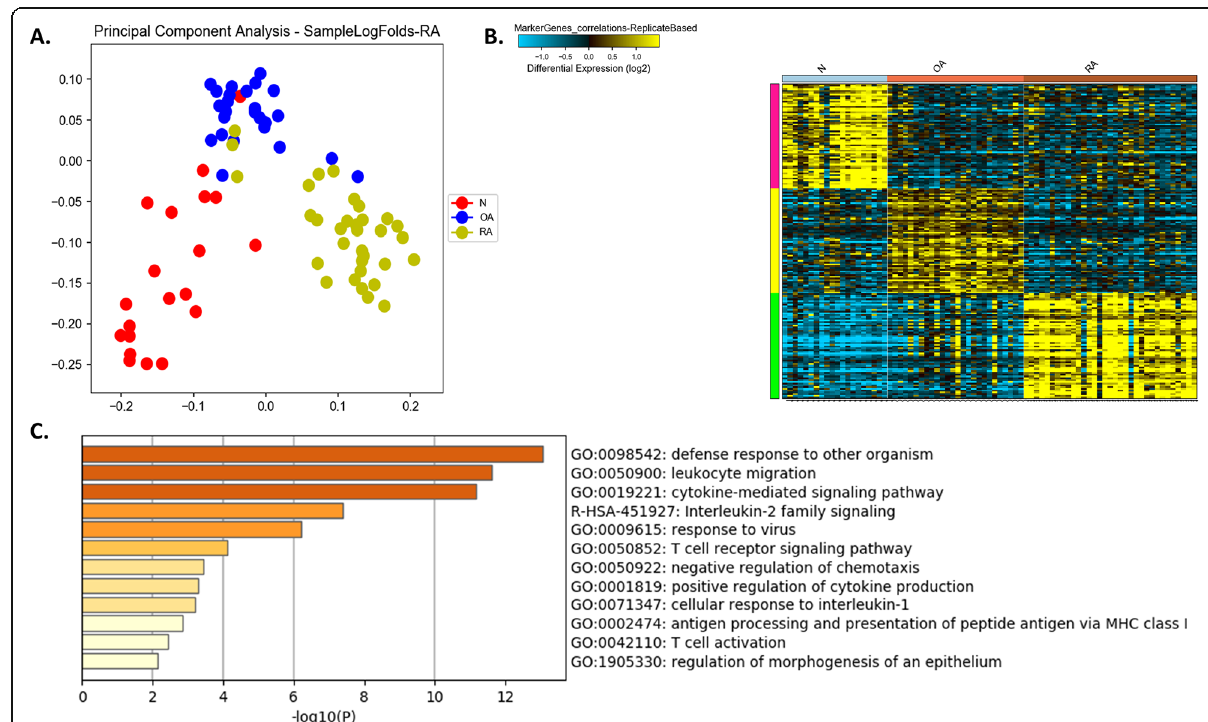
Fig. 1 Comparison between the synovium transcriptomics profile of rheumatoid arthritis (RA) patients versus healthy controls (N) and osteoarthritis (OA). a principle component analysis (PCA) showing that the top selected DEGs can cluster the groups precisely b Heatmap of the top markers that can differentiate the three groups and c shows top pathways enriched in RA specific markers